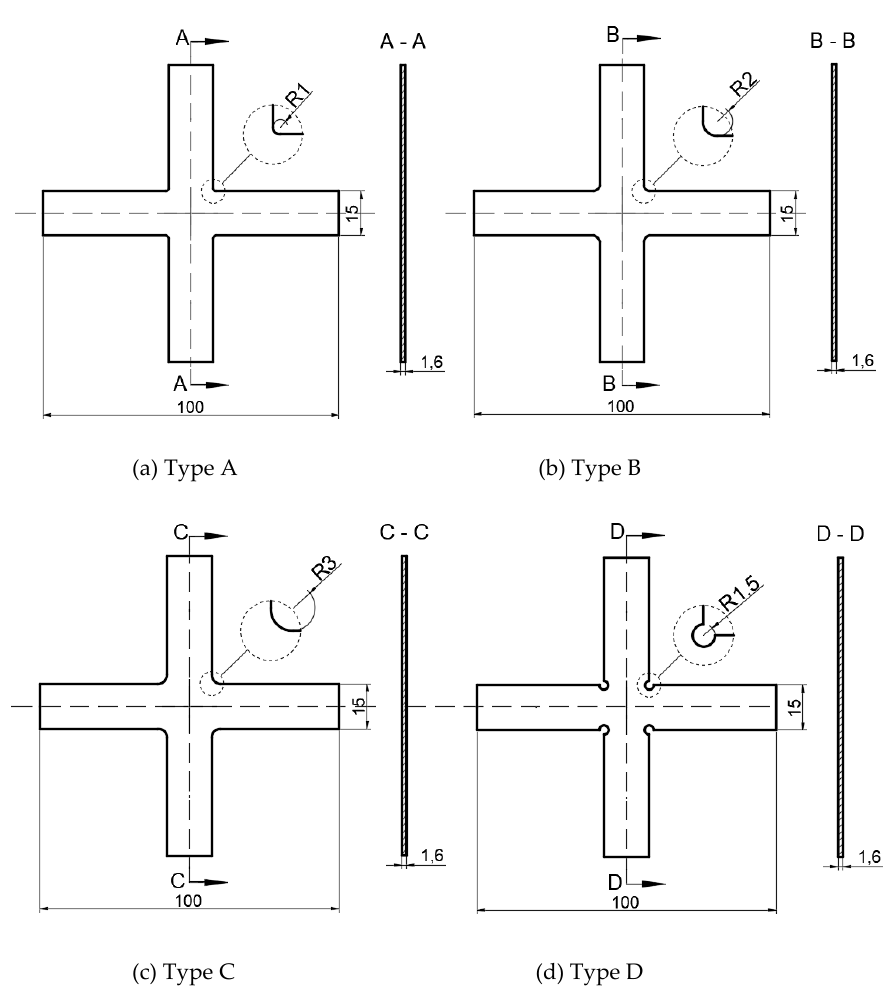
Figure 4. Shape and dimensions of the designed test specimen (unit: mm).